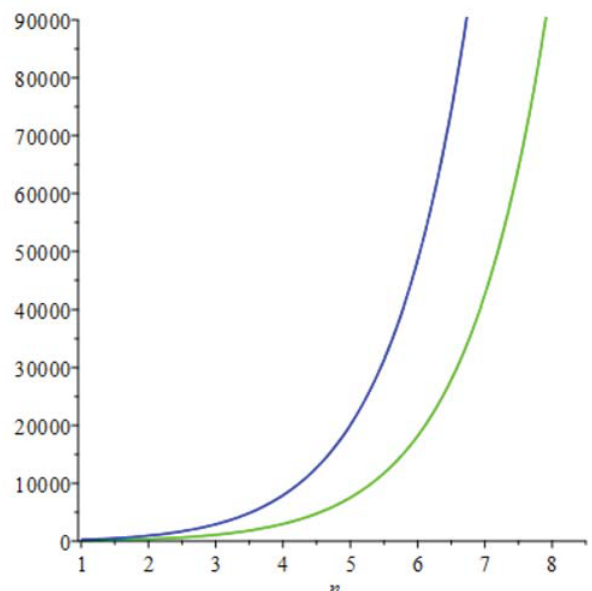
Figure 3: Comparison of the eccentric-connectivity index ξ ( SD [r]) and PD [r]. The colors red and blue represents the eccentric-connectivity index ξ ( SD [r]) and PD [r], respectively. We can see that in the given domain the eccentric connectivity index of PD [r] is more dominating.